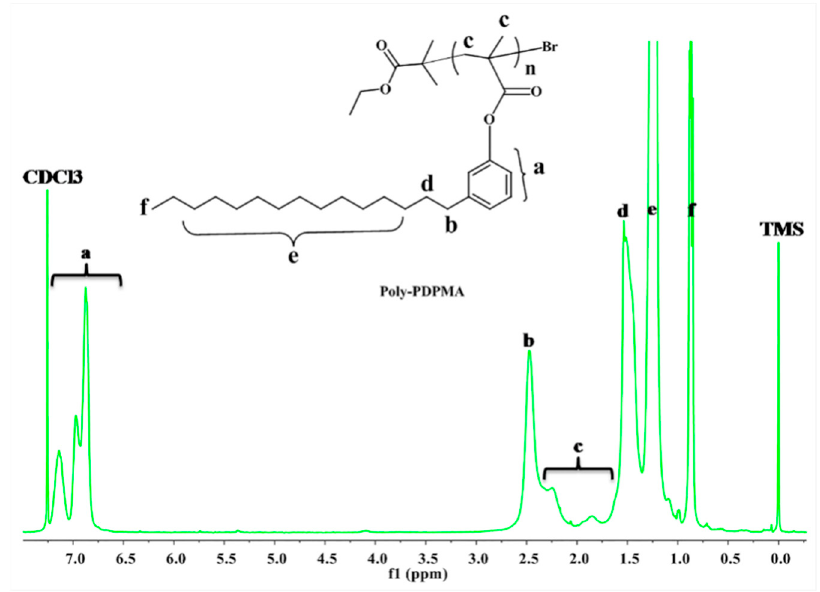
Figure 1. 1 H NMR spectrum of pentadecylphenylmethacrylatehomopolymer (poly PDPMA).